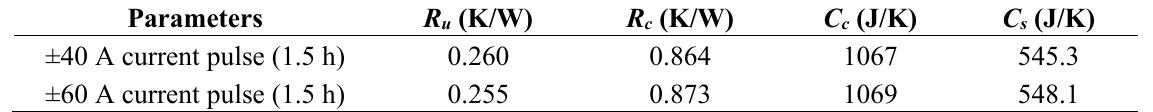
Table 1. The thermal parameters identification